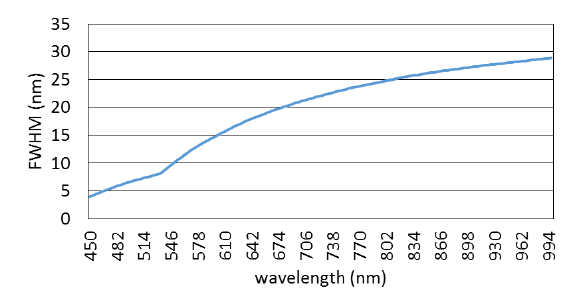
Figure 1. FWHM as given by the